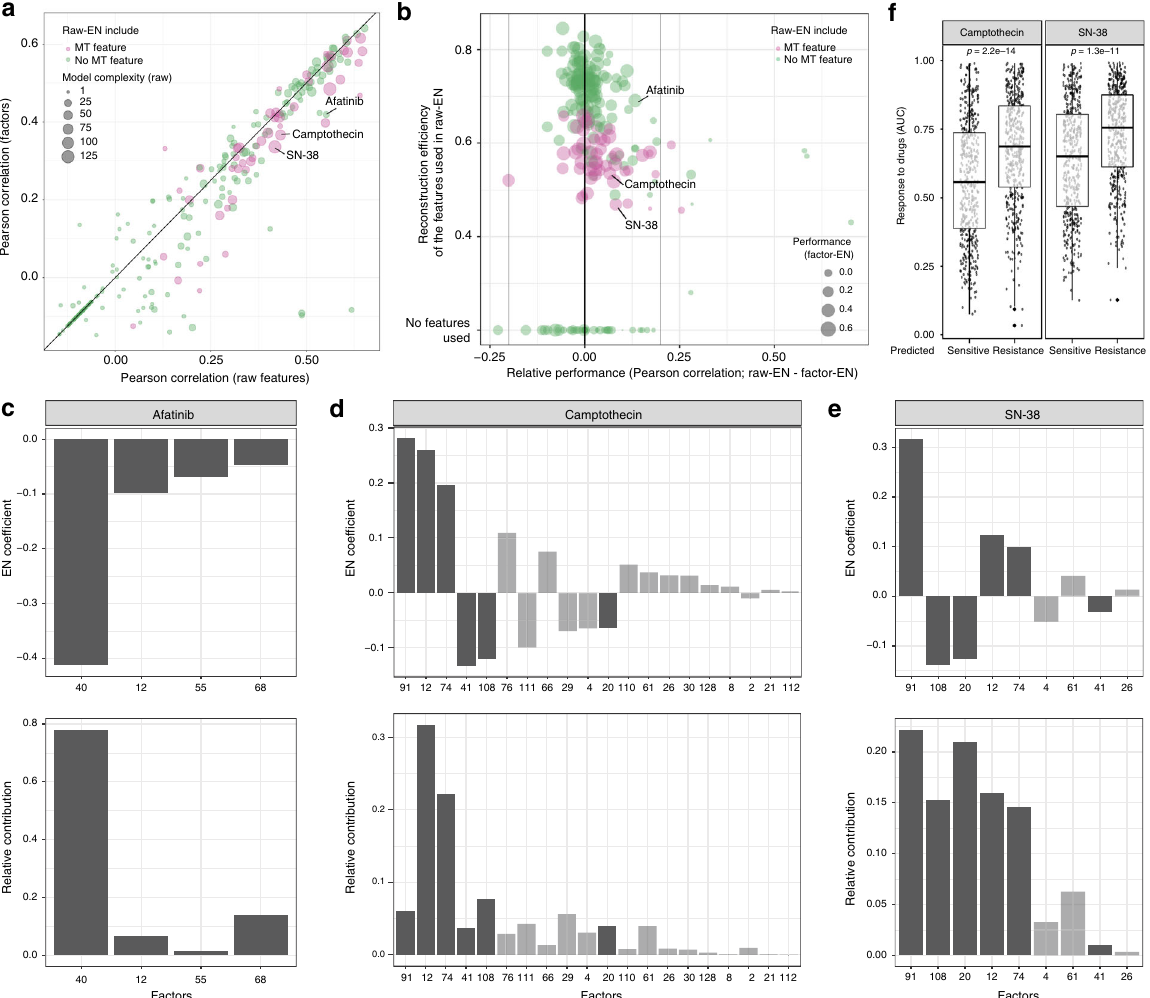
Fig. 3 Associations between factors with tissue type, pathways and drug responses. a Predictive performances of ENs trained with raw features ( x -axis) and factors ( y -axis) for 265 compounds in Pearson correlation. Usage of mutation data and the total number of features selected in the raw feature-based are indicated by node color and size. b The relative prediction performance of ENs trained with raw features (raw-EN) and factors (factor-EN; x -axis), compared with the reconstruction ef fi ciency of the features in raw-EN model (average explained variation of the selected features by WON-PARAFAC; y - axis) in a scatter plot. Node color/size indicates the use of mutation data by raw-EN and performance of factor-EN, respectively. c – e EN coef fi cient (top; y - axis) and relative contribution (bottom; y -axis) of the factors ( x -axis) predicts response to Afatinib ( c ), Camptothecin ( d ) and SN-38 ( Irinotecan ; e ). The dark bar indicates the six factors used in the downstream analysis. For Camptothecin and SN-38, we selected the union of the top fi ve factors with the largest absolute EN coef fi cients from in the two EN models. f Comparison of response to Camptothecin (left panel) and SN-38 ( Irinotecan ; right panel) between cell lines with higher loadings on sensitivity (predicted sensitive; left boxplot) and resistance factors (predicted insensitive; right boxplot), respectively. Standard notations are used for elements of the boxplot (i.e. upper/lower hinges: 75th/25th percentiles; inner-segment: median; and upper/lower whiskers: extension of the hinges to the largest/smallest value at most 1.5 times of interquartile